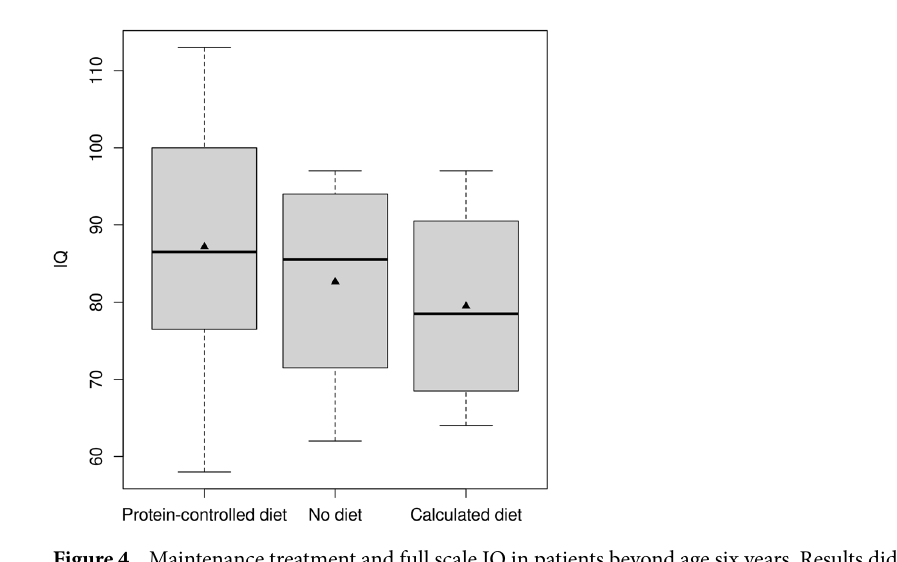
showed homogenous results for HE (p = 0.7184) and LE patients (p = 0.7676). However, results differed signifi-